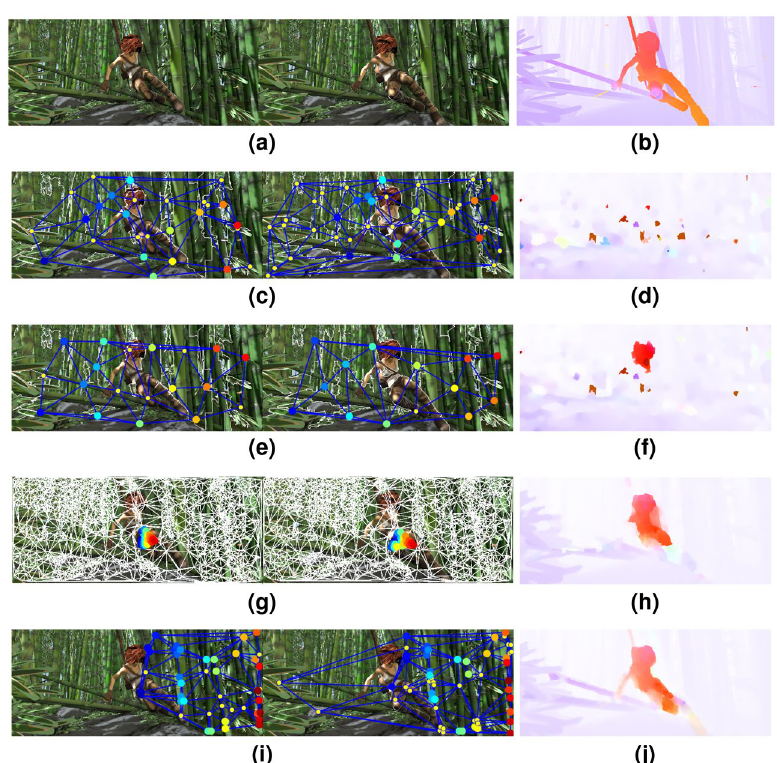
Figure 6. Graph Matching with different initial coarse-scale clustering methods on the pair of images shown in Figure ( a ). The initial coarse-scale clusters are resulting from Felsenszwalb’s 34 graph-based segmentation (Figure ( c ), SLIC superpixels 29 (Figure ( e )), Delaunay triangulation of rootSIFT features (Figure ( g )) and clustering of feature descriptors (Figure ( i )). Figure ( d,f,h,j ) shows the optical flow results corresponding to each technique; ground truth shown in Figure ( b